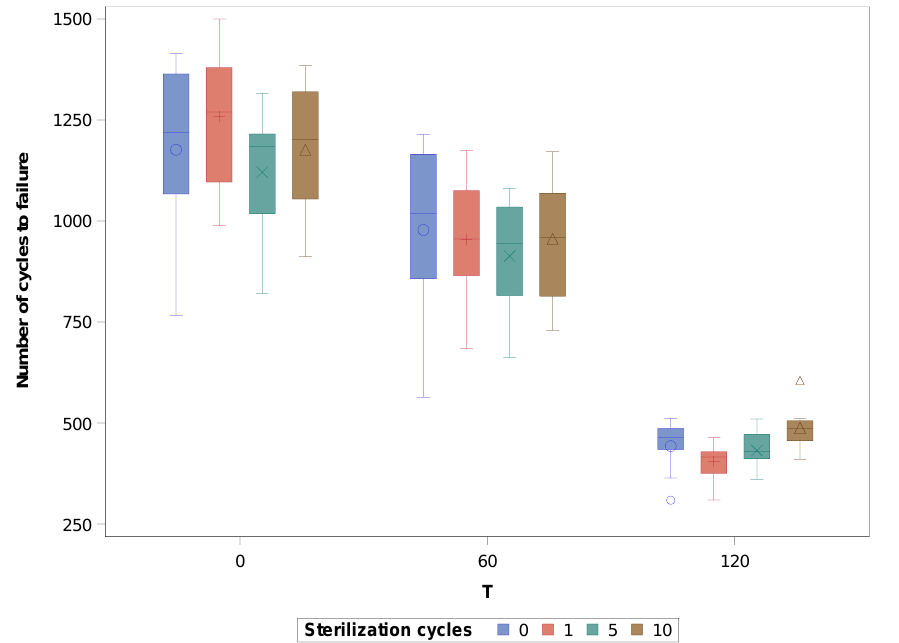
Figure 5. Box plot of the number of cycles to failure for the time of use and the sterilization cycles study groups. The horizontal line in each box represents the median value.